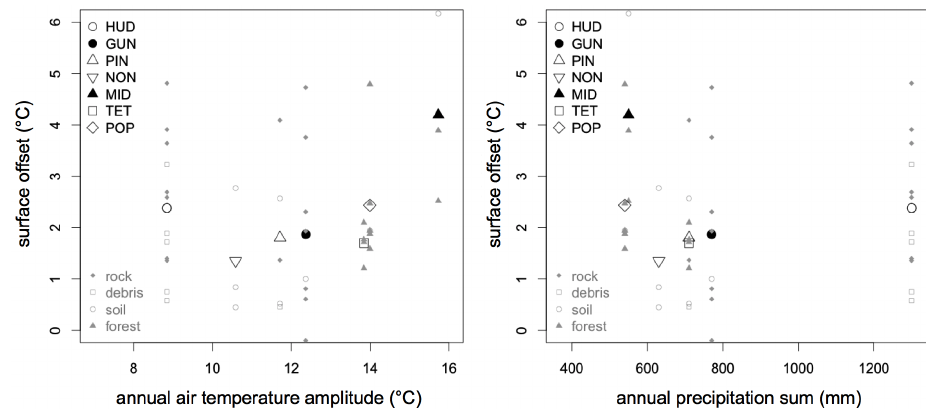
Figure 5. Surface offsets (SO) against macroclimatic parameters. Large symbols are means per site and small symbols are individual locations with symbol given by surface type. Left: SO against measured annual amplitude of air temperature (ATA = ( T july − T jan )/ 2); right: SO against annual precipitation sum (precipitation estimate from Wang et al.,